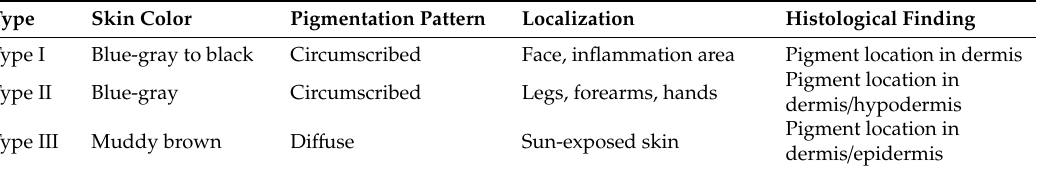
Table 1. The characteristics of three main types of minocycline-induced